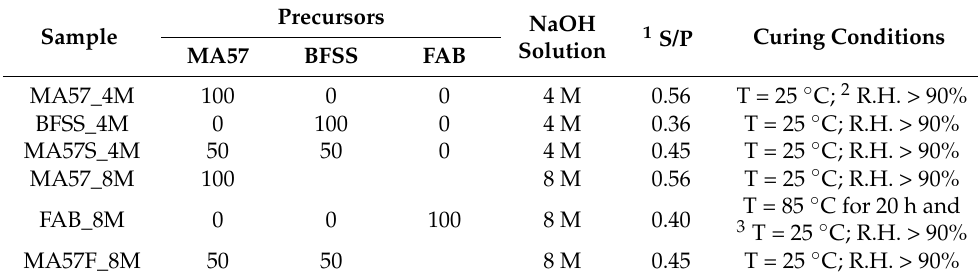
Table 2. Details of formulation and curing conditions of AABs. Sample